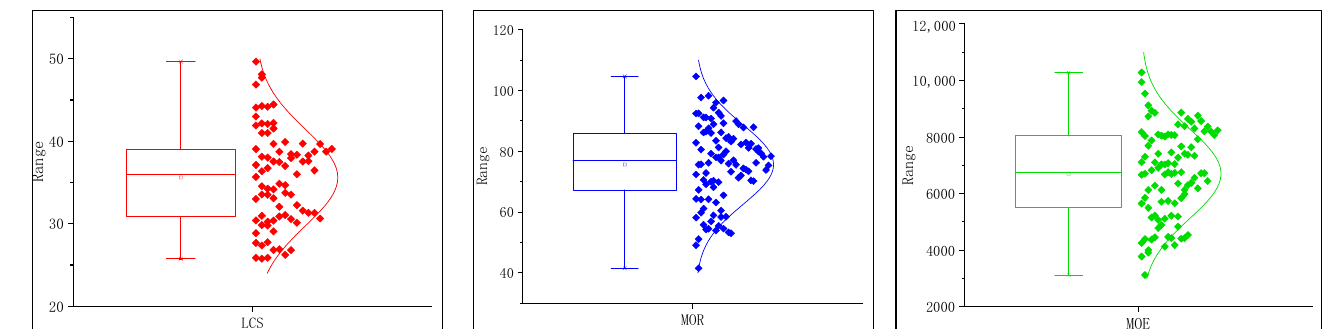
Figure 1. Ranges of mechanical properties of larch wood.